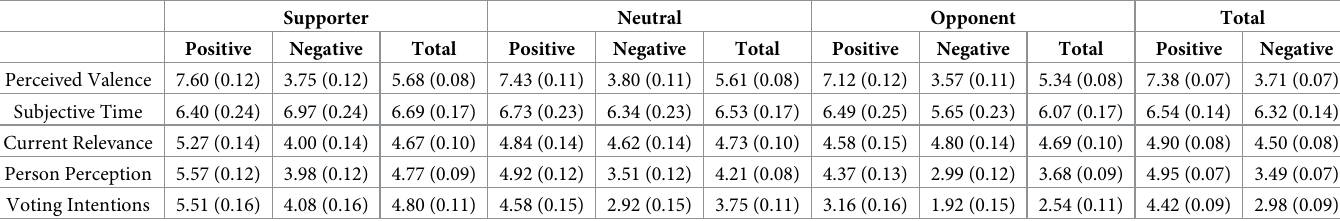
than controls, p = .006. Within the positive condition, opponents rated the review as signifi- cantly less relevant than supporters, p < .001, and no different from controls, p = .188. Sup- porters rated the positive review as significantly more relevant than controls, p = .026. Table 4. Estimated marginal means and standard errors by cell for each of the dependent variables. Supporter Neutral Opponent Total Positive Negative